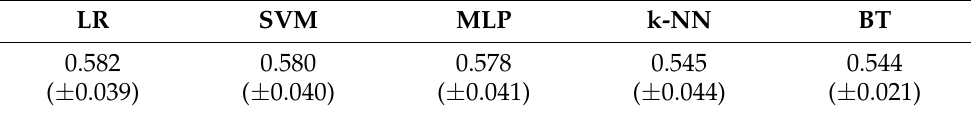
Table 1. AUC for different classifiers with the original dataset (without performing feature